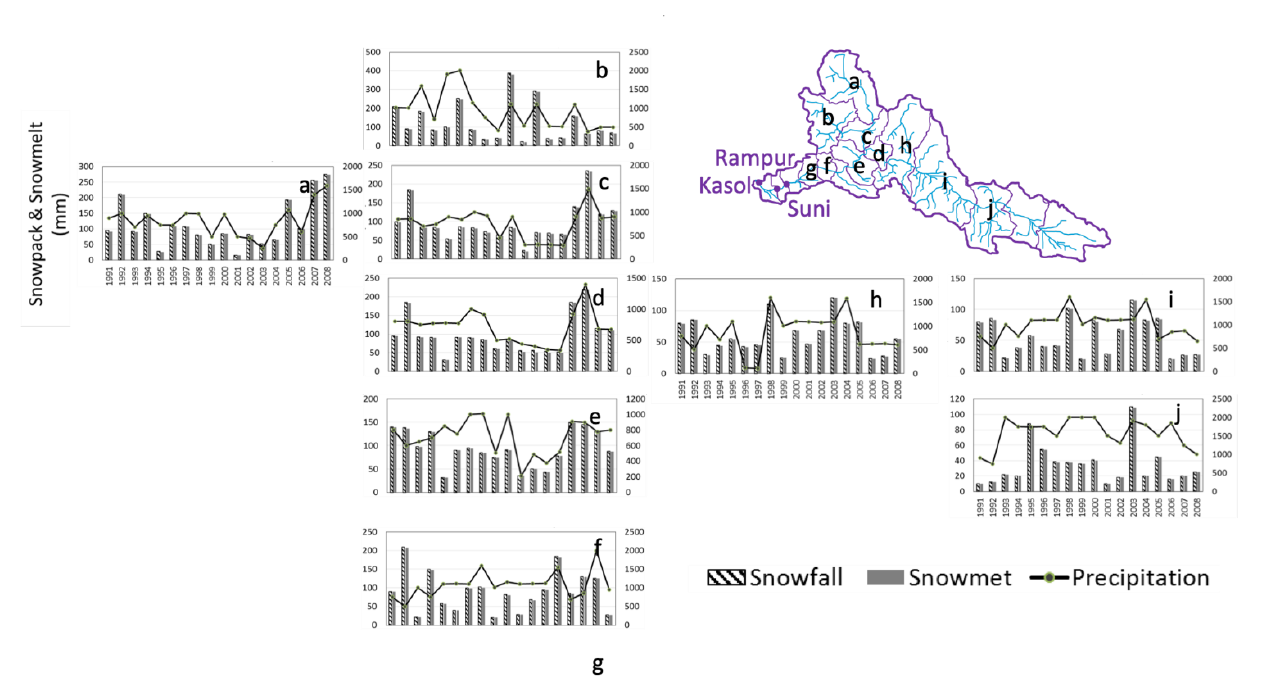
Figure 3. Annual variability of snowpack and snowmelt and precipitation at sub-catchment scale for the year 1991 to 2008. Following drainage areas in Figure 1b, the stations above drain from left to right: ( a ) SB1: from top to bottom; ( b ) SB2; ( c ) SB3; ( d ) SB4; ( e ) SB6; ( f ) SB8: from ( j ) SB14 to ( i ) SB7: from right to left ( i ) SB7 to ( h ) SB5; and ( g ) SB13.